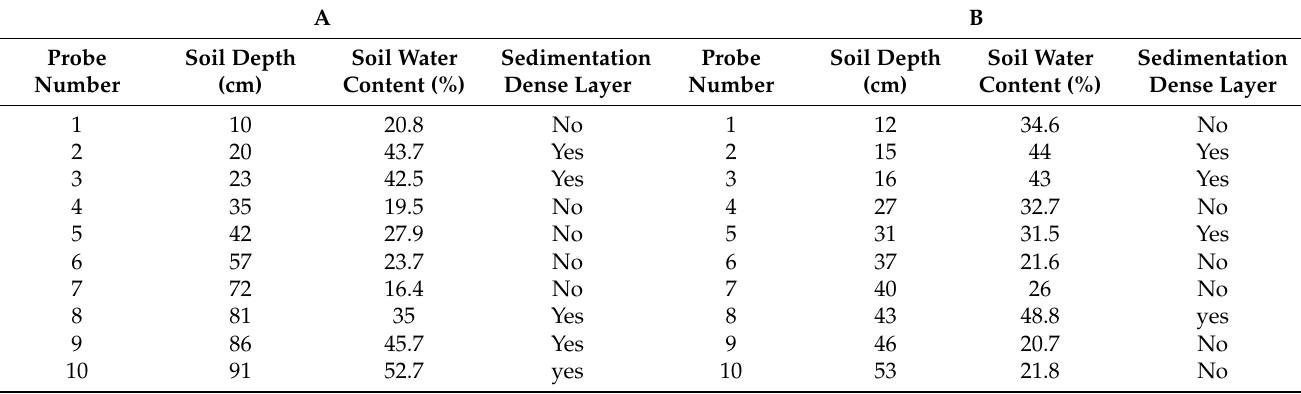
Table 2. Initial soil water statistics.